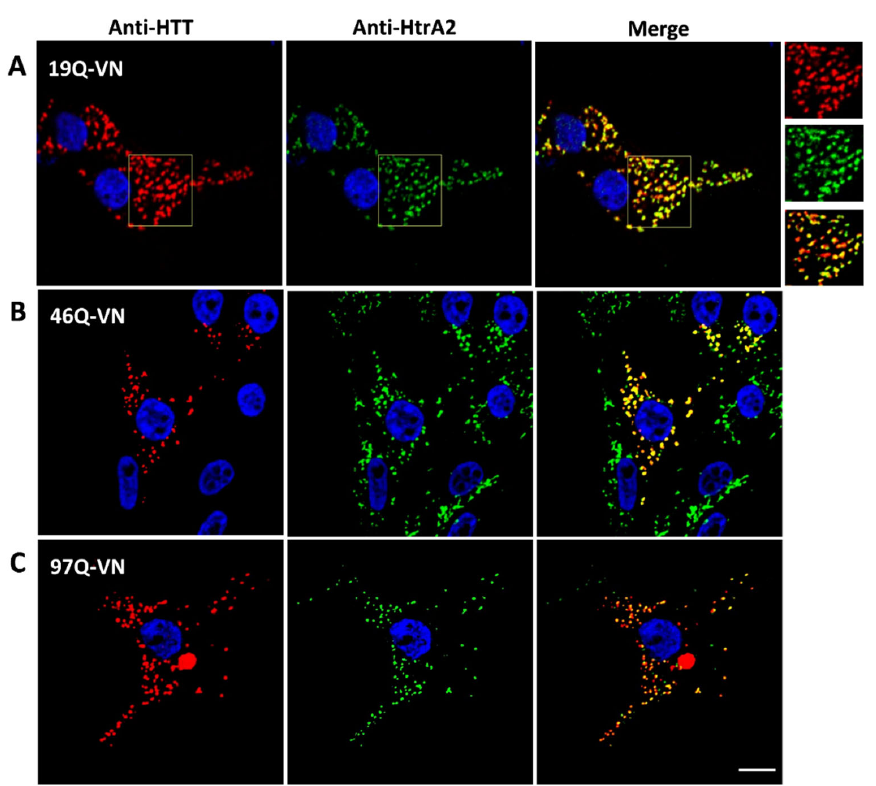
Figure 5. Subcellular localisation of HTT-VN constructs. HEK293T cells were transfected for 48 h with either 19Q-VN, 46Q-VN or 97Q-VN, then fixed and immunolabelled. ( A ) Co-localisation analysis of 19Q-VN and mitochondrial fluorescent signals on deconvolved confocal optical z-sections, using JACoP plugin in ImageJ. Left panel, 19Q-VN immunolabelling of anti-HTT (mEM48) antibody (MAB5374), (Alexa Fluor 647). Middle panel, mitochondrial immunolabelling of anti-HtrA2/Omi antibody (AF1458) (Alexa Fluor 555). Right panels: merge image of the HTT and mitochondrial signals. Nuclei were stained with Hoechst 33342. Scale bar = 8 µ m. Co-localisation analyses were carried out on the regions of interest indicated on the images, and an enlarged image is presented on the right of panel (A). The 19Q-VN signal appears punctate and co-localises majorly with mitochondrial, 82.7% (Pearson’s correlation). Analysis was performed on the presented images. ( B , C ) Left panel: anti-HTT (mEM48) antibody (MAB5374) (Alexa Fluor 647), (B: 46Q-VN, C: 97Q-VN). Middle panel: anti-HtrA2/Omi antibody (AF1458) (Alexa Fluor 555). Right panel: merge of HTT and mitochondrial signals. Nuclei were stained with Hoechst 33342. Scale bar = 8 µ m. Anti-HTT signal co-localises with the mitochondrial signal, but the presence of aggregates (bright inclusions) makes images unquantifiable. HTT-VN and mitochondrial signals are presented with red and green signals for Alexa Fluor 647 and 555,